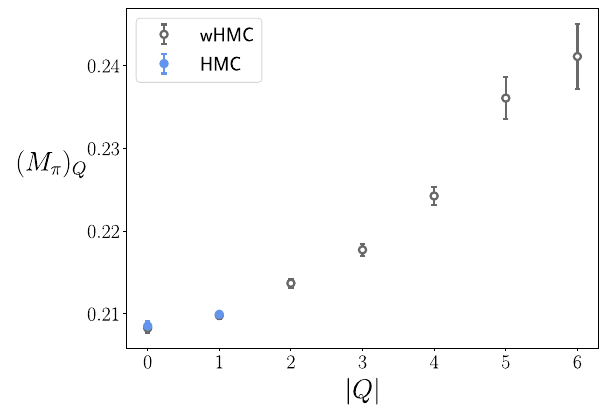
Fig. 15 Pion mass at fixed topology, ( M π ) Q , versus Q at β = 9 . 0 for wHMC and HMC